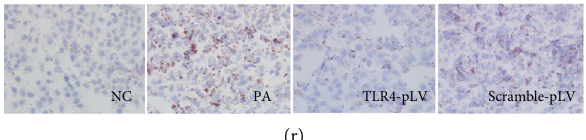
Figure 4: AP-1 siRNA transfection extenuated PA-induced in fl ammation in RAW264.7 cells and metabolic disorders in cocultured AML hepatocytes. AP1 siRNA transfection signi fi cantly diminished PA-induced elevation of the AP1 expression in RAW264.7 cells (a – e). AP1 siRNA transfection seemed to exacerbate the increases of the TLR4 expression in these cells (f – h). AP1 siRNA transfection diminished the DNA binding activity of AP1, but it seemed not be able to meliorate PA-induced increases in the CD11c mRNA expression or decreases in the CD206 mRNA expression (i, j). AP1 siRNA transfection was not able to palliate PA-induced augmentation in JNK phosphorylation (k), as well as in the mRNA expression and DNA binding activity of NF- κ B (l, m). AP1 siRNA transfection alleviated the increases in proin fl ammatory factor (IL-1 β , IL-6, and TNF- α ) expression in RAW264.7 macrophages and TNF- α and IL-6 levels in the supernatant (n, o) and attenuated PA-induced decreases in the IL-10 expression (n). AP1 siRNA transfection in RAW264.7 macrophages signi fi cantly moderated the decreases in AKT phosphorylation level and lipid accumulation in cocultured AML12 hepatocytes (p – r). Data are presented as mean ± SEM ; ∗ p < 0 : 05 and ∗∗ p < 0 : 01 compared with the NC group; & p < 0 : 05 and && p < 0 : 01 compared with the Scramble-pLV group (d, n, o, q); # p < 0 : 05 and ## p < 0 : 01 compared with the PA group (e, j, n, o,